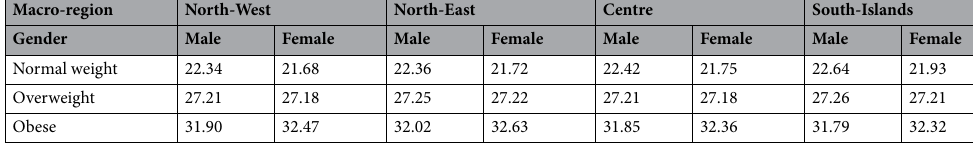
Table 4. Average BMI values for the Italian population by weight condition, gender, and macro-regions. BMI is the ratio between weight (kg) and square of height (m). A BMI ranging from 18.5 to 25 is associated with a normal weight, values between 25 and 30 indicate an overweight condition, greater than 30 they indicate